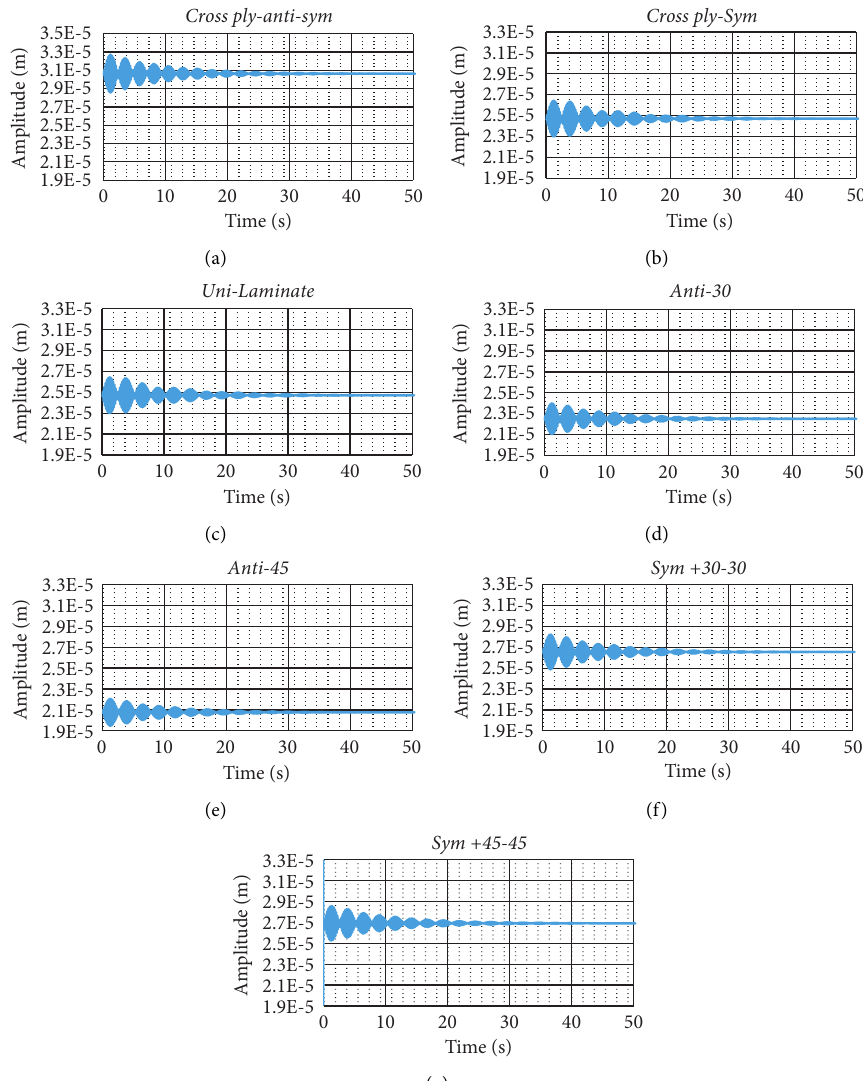
Figure 3: Illustration of the response of the laminates for the abrupt heat flux in all graphs.